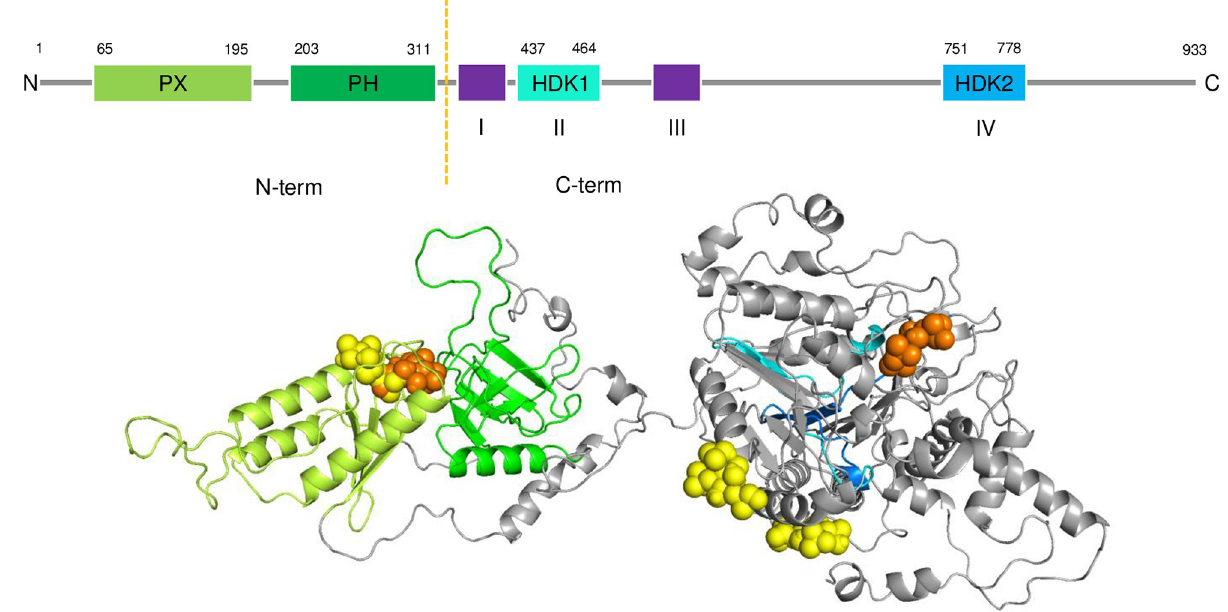
Fig 5. Docking of tail-truncated PIP 2 on the hPLD2 model. (top) The modular architecture of hPLD2 gene: domains PX (pbox consensus sequence) and PH (pleckstrin homology) are located in N-term (residues from 1 to 325), while C-term (326 to 933) contains four evolutionary conserved sequences (I − IV), where II and IV are HDK motifs. (bottom) Five most stable binding poses of tail-truncated PIP 2 (singly-protonated at P4) shown as orange/yellow ball representations. The orange represents the most stable pose for each segment (N-term or C-term). Coloring of named protein regions; PX, light green; PH, green; HDK1, cyan; HDK2,